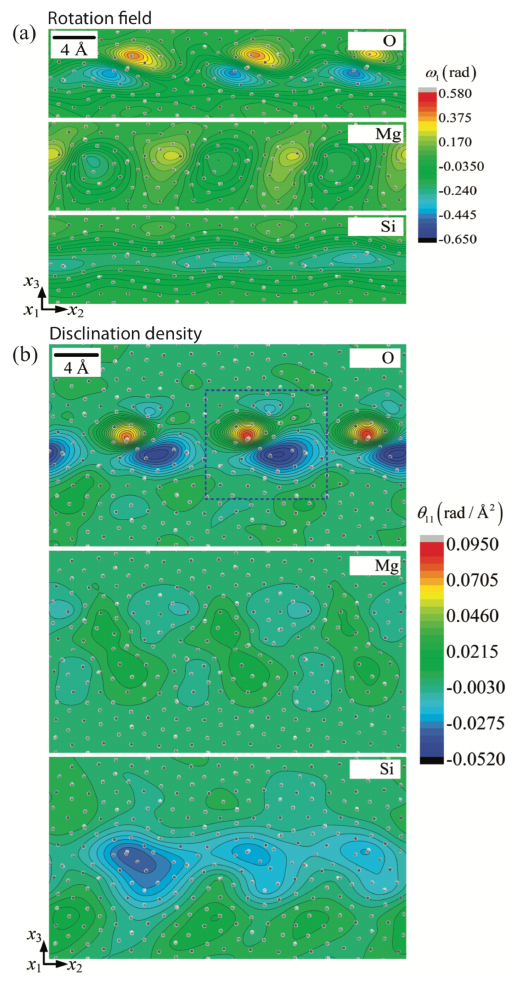
Figure 13. Disclination dipoles along a high-angle (60.8 ◦ ), sym- metric, tilt grain boundary in forsterite, obtained by molecular dy- namics simulation (reproduced from Sun et al., 2016). (a) The ro- tation field for ω 1 , shown for the three atoms of reference in the forsterite lattice: O (grey), Mg (dark grey), and Si (white). The ro- tation field can be extracted from high-spatial-resolution and high- angular-resolution EBSD maps, even if the scale of observation is not the same. Smaller EBSD steps provide a higher resolution of the disclinations and their dipoles but greater disclination density; thus special care must be taken when comparing EBSD maps. See Cordier et al. (2014) and Thieme et al. (2018) for in-depth discus- sion of geometrically necessary dislocation and disclination densi- ties. (b) The disclination density for disclination θ 11 . The square with a dashed blue outline indicates a disclination dipole. For refer- ence, x 1 , x 2 , and x 3 are reference axes (see Sun et al., 2016).